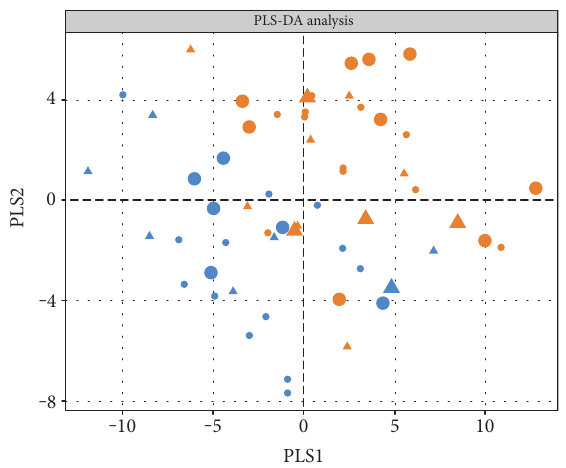
Figure 1: CADpatientsseparated fromnon-CAD subjects.PLS-DA (partial least squares discriminant analysis) results are shown. Subjects with CAD are depicted in yellow and subjects without CAD in blue; medication intake is displayed as insulin therapy (circle) or oral antidiabetic agent intake (triangle); sex di ff erences are highlighted in the size of the symbols: females (larger) and males